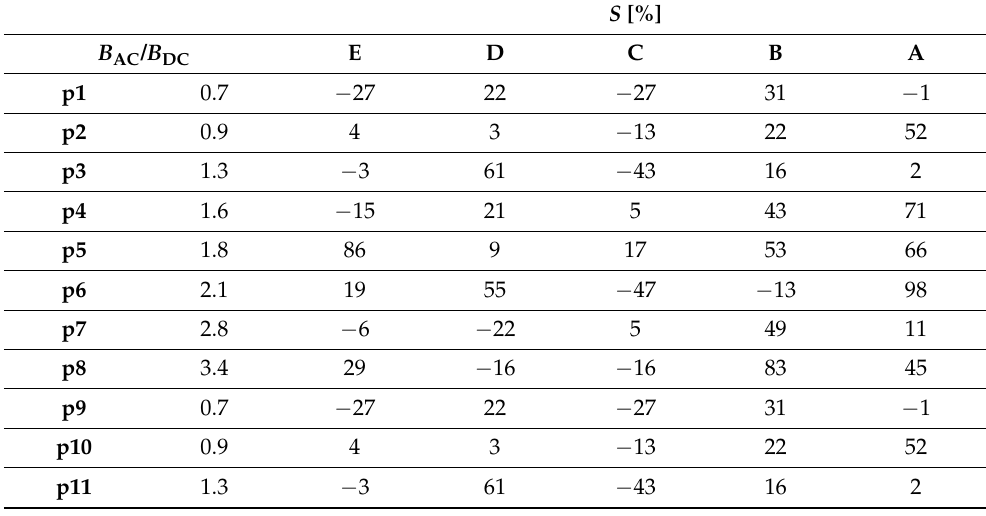
Table 2. The percentual response rate of a biological system on the change in the induction ratio.